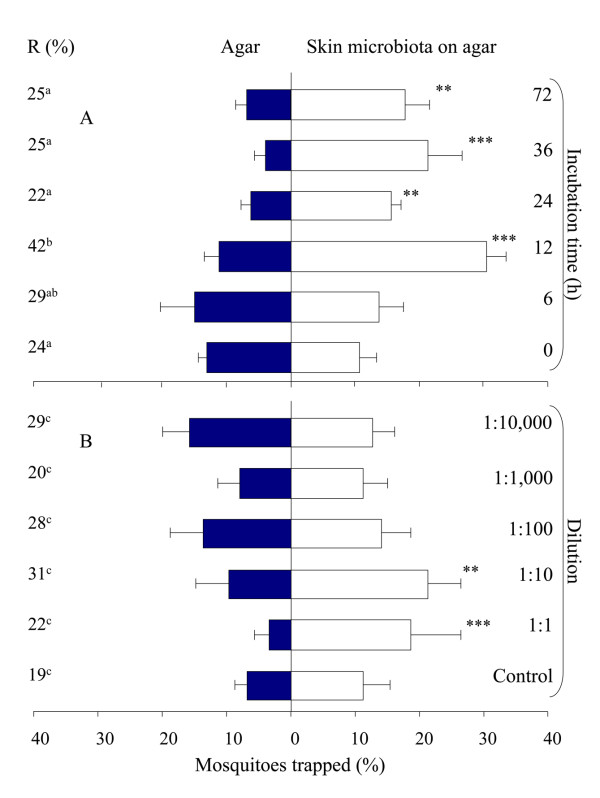
Mean response of An. gambiae to skin microbiota in an olfactometer. Microbiota were grown on blood agar and tested at different times of incubation (A) and in different dilutions of the most attractive treatment (12 h incubation) (B). Six times 30 mosquitoes were released per treatment. Error bars represent standard errors of the mean; ***: χ2-test P < 0.001; **: χ2-test P < 0.01. R = The trap entry response expressed as the number of female mosquitoes caught in both trapping devices divided by the number of mosquitoes that flew out of the release cage. Data followed by different letters differ significantly at P < 0.05 (GLM).